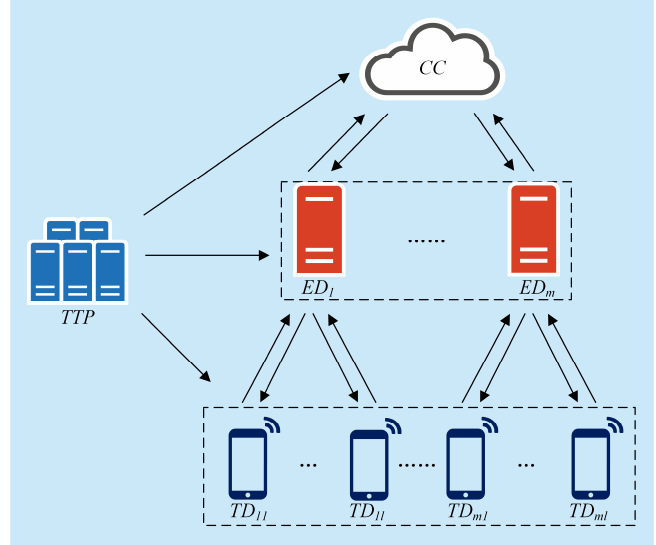
Figure 1. The system model of the proposed PLSA-FT scheme.